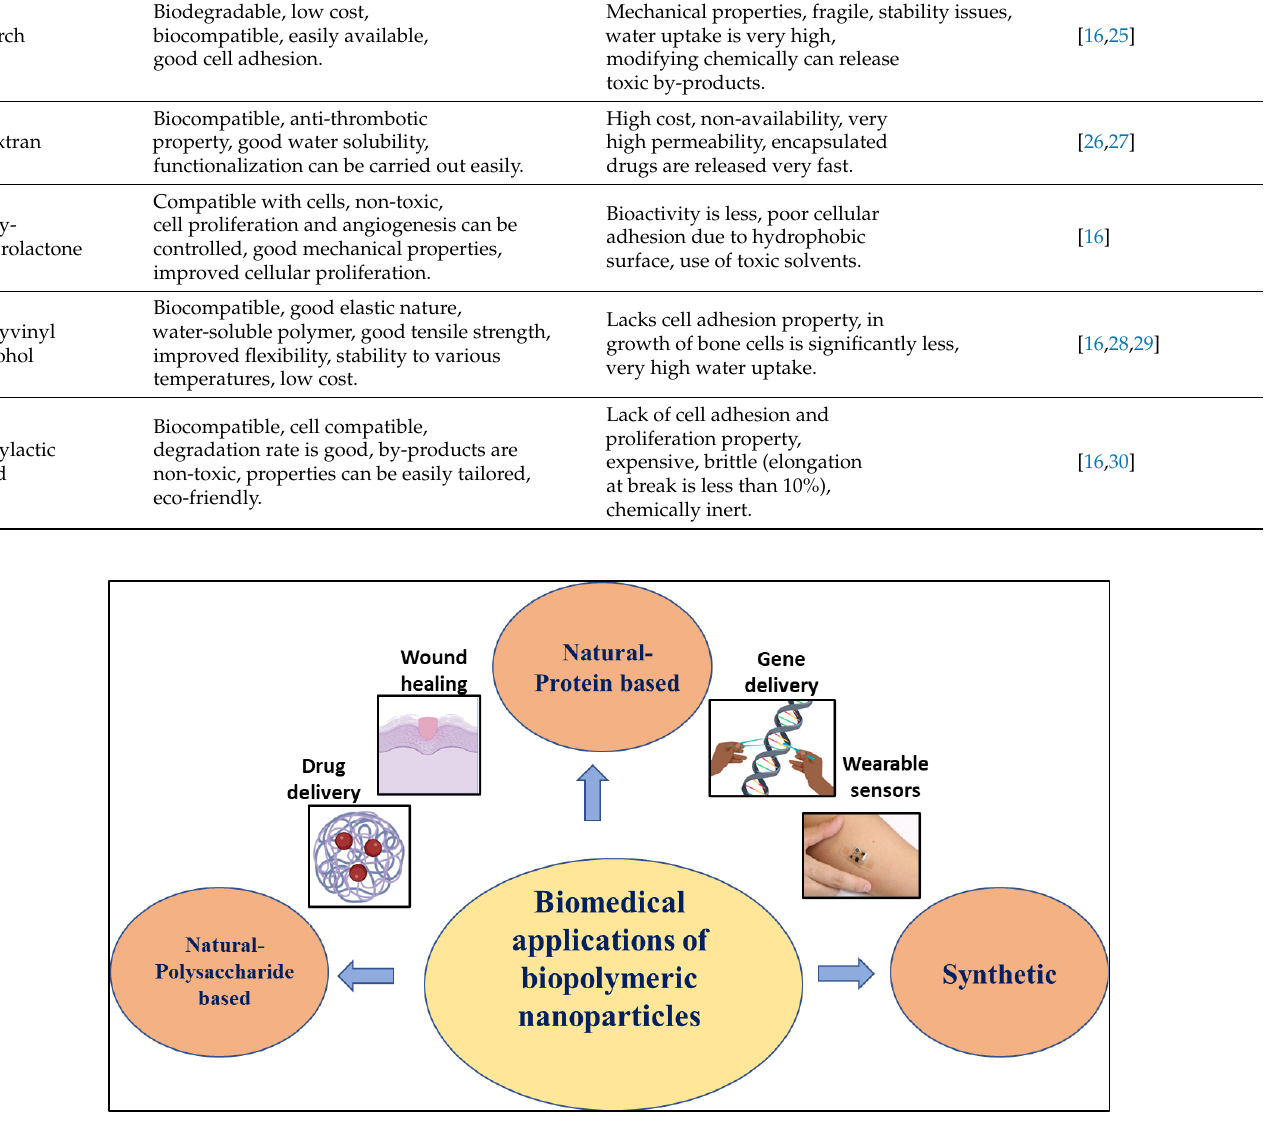
Figure 1. Schematic representation of the biomedical applications of biopolymeric nanoparticles.